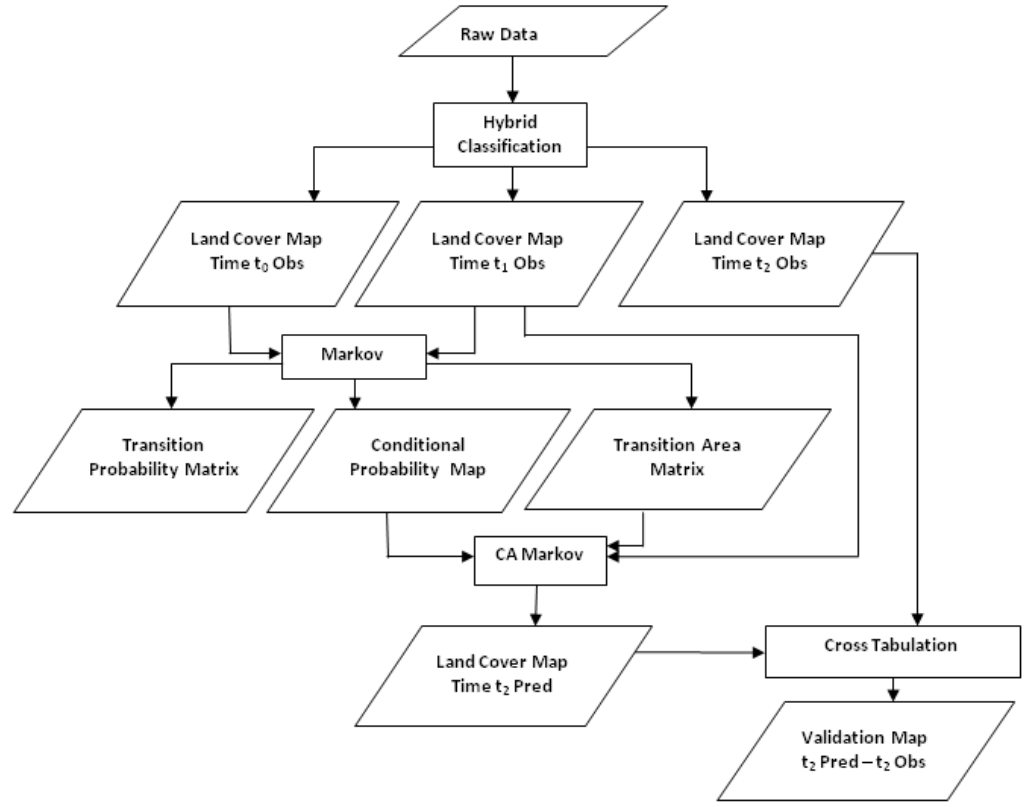
Figure 2. Method of land cover classification and CA Markov model . Steps leading to the prediction of land-cover classes.